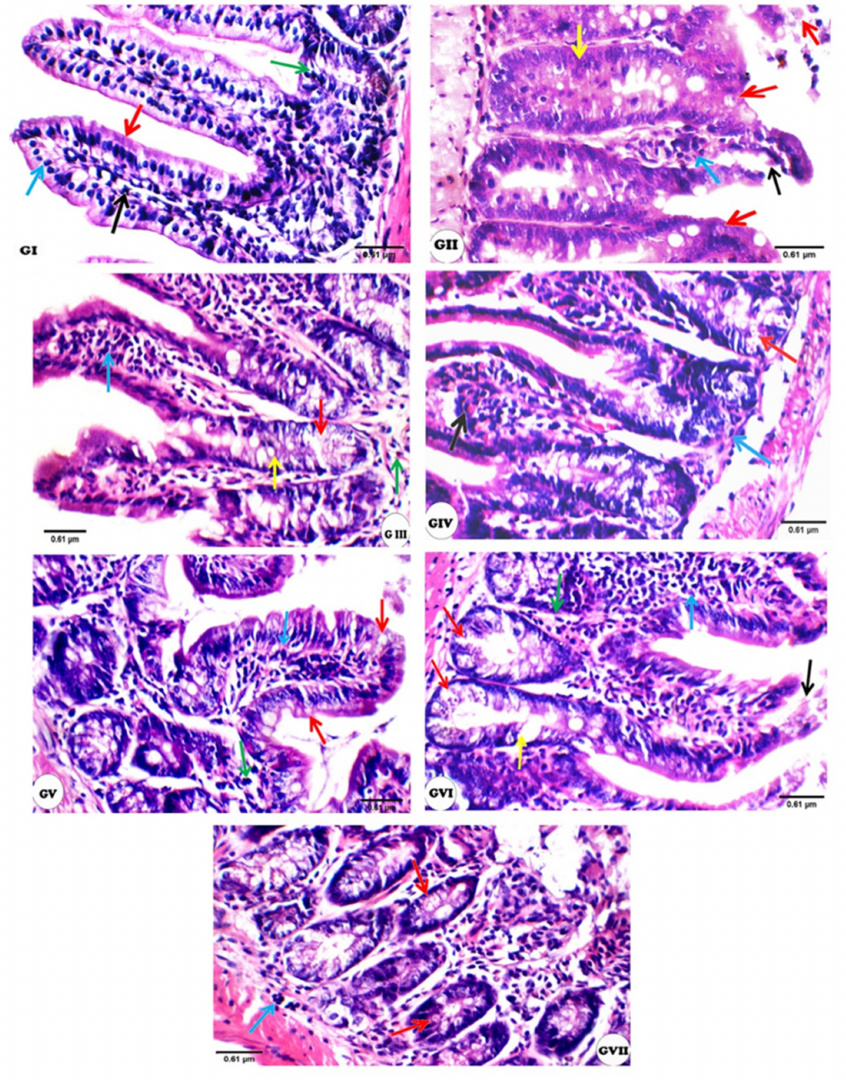
Figure 3. The changes in the intestinal sections of different experimental groups (H&E at high power view × 400): GI; (Negative control): showing average villi/crypt ratio and villi composed of connective tissue core (black arrow) covered by tall columnar epithelial cells (blue arrow) with intact brush border (red arrow), and average crypts (green arrow), GII (Positive control); showing very short and thin villi with loss of epithelial covering (black arrow), excess oocysts in superficial mucosa (red arrow) with mild interstitial (blue arrow) and submucosal inflammatory infiltrate with scattered eosinophils (green arrow), and markedly elongated crypts (yellow arrow), GIII (Drug-treated); showing relatively short villi (black arrow), scattered oocysts in the crypts (red arrows) with mild intra-villous (blue arrow) and submucosal inflammatory infiltrate with scattered eosinophils (green arrow), and relatively elongated crypts (yellow arrow), GIV (tested extract ratio 1:1); showing broad villi (black arrow), scattered oocysts in the crypts (red arrows) with mild intra-villous inflammatory infiltrate (blue arrow), GV (tested extract ratio 1:3); showing relatively short broad villi (black arrow), scattered oocysts in superficial mucosa (red arrows) with mild intra-villous (blue arrow) and interstitial inflammatory infiltrate (green arrow), GVI (tested extract ratio 1:5); showing relatively short broad villi with partially necrotic tip (black arrow), excess oocysts in the crypts (red arrow) with marked intra-villous (blue arrow) and interstitial inflammatory infiltrate (green arrow), and relatively elongated crypts (yellow arrow), GVII (tested extract ratio 1:7); showing scattered oocysts in the crypts (red arrows) with marked interstitial (black arrow) and mild submucosal inflammatory infiltrate with scattered eosinophils (blue